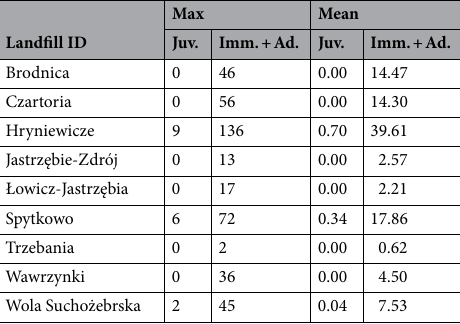
Table 2. Maximum and mean numbers of storks observed per hour on each landfill. Juv. juvenile individuals, Imm. immature individuals, Ad. adult individuals.